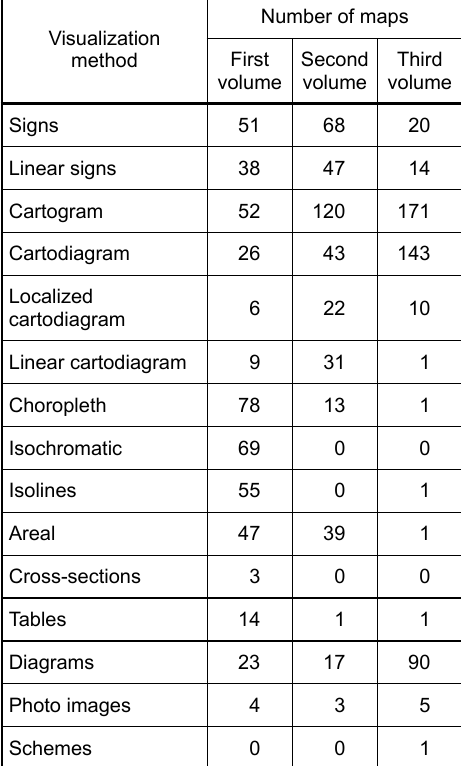
Table 1. Methods of cartographic visualization of Lithuanian national atlas maps Visualization